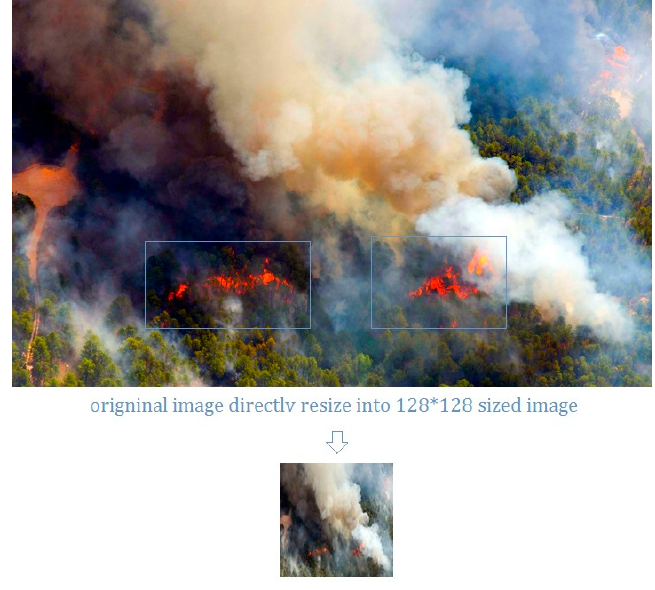
Figure 2. Direct resizing leads to detail loss.